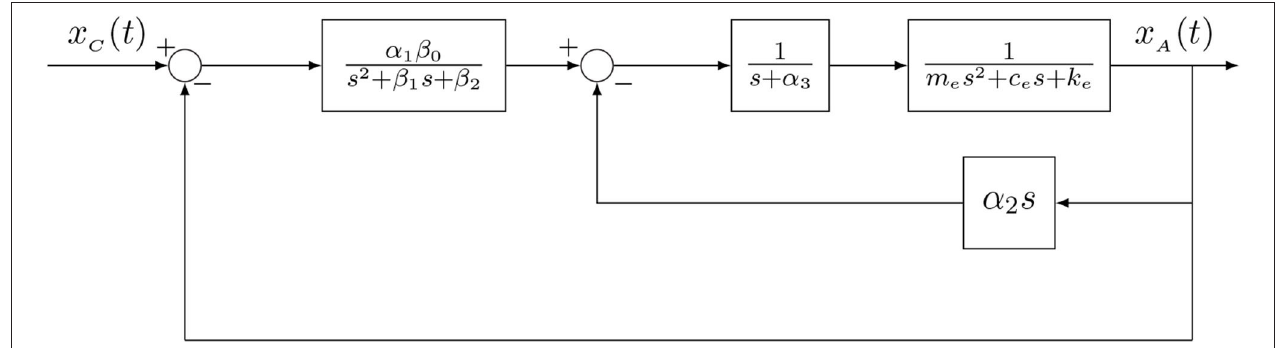
FIGURE 5 | Layout of the control plant. From left to right, the transfer functions on the upper branch correspond to the valve, actuator and experimental substructure dynamics, respectively, while the transfer function on the inner feedback loop corresponds to the control-structure interaction dynamics. Adapted from Silva et al. (2020) with permission from